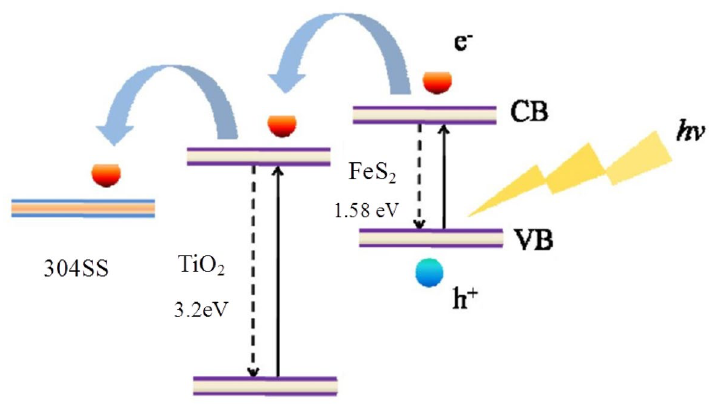
Figure 10. The mechanism schematic diagram of the photoelectochemical cathodic